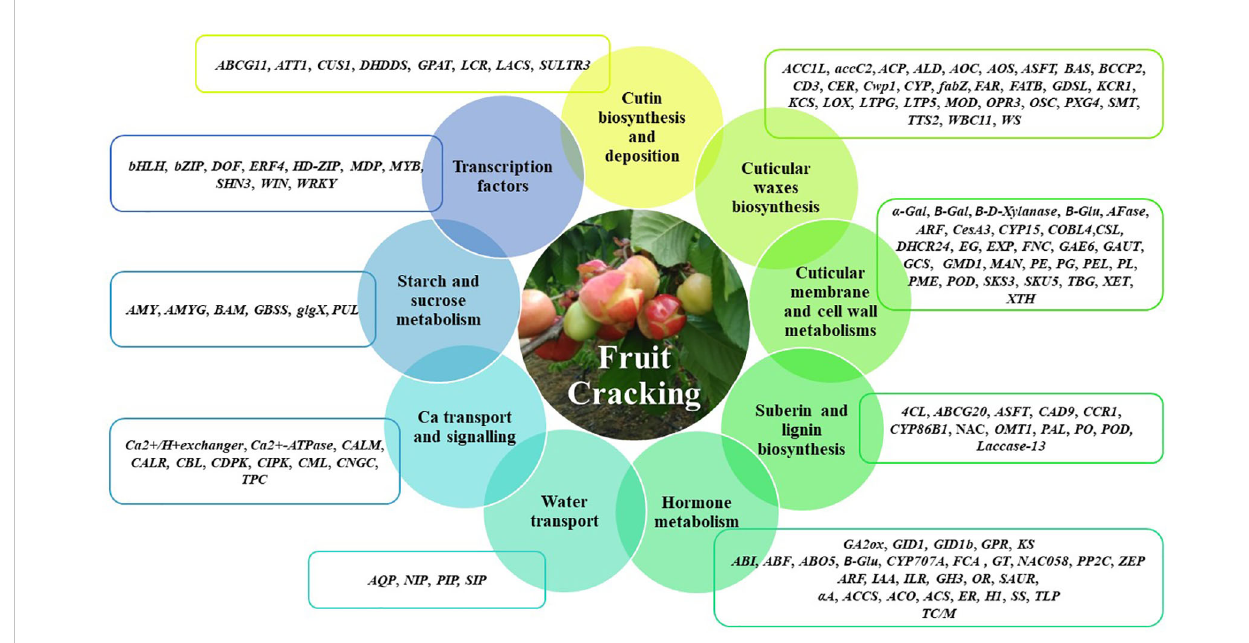
FIGURE 1 Main gene classes potentially involved in fruit cracking. The genes described belong to the molecular functions of cutin biosynthesis and deposition, cuticular waxes biosynthesis, cuticular membrane and cell wall metabolisms, suberin and lignin biosynthesis, hormone metabolism, water transport, Ca transport and signaling, starch and sucrose metabolisms and transcription factors. Cutin biosynthesis and deposition - ABCG11 (ATP binding cassette transporter), ATT1 (Cytochrome P450 oxidase CYP86A2), CUS1 (cutin synthase 1), DHDDS (ditrans,polycis-polyprenyl diphosphate synthase), GPAT (Glycerol-3-phosphate acyltransferase), LCR (Cytochrome P450 oxidase CYP86A8), LACS (Long chain fatty acid – CoA synthetase), SULTR3 (sulfate transporter 3) ; Cuticular waxes biosynthesis - ACC1L (acetyl-CoA carboxylase 1-like), accC2 (biotin carboxylase 2, chloroplastic), ACP (Acyl carrier protein), ALD (aminotransferase ALD, chloroplastic-like), AOC (oxide cyclase), AOS (allene oxide synthase), ASFT (Aliphatic suberin feruloyl- transferase), BAS (Beta-amyrin synthase), BCCP2 (biotin carboxyl carrier protein of acetyl-CoA carboxylase 2, chloroplastic), CD3 (cutin de fi cient 3), CER (Eceriferum family), Cwp1 (cuticular water permeability), CYP (cytochrome-P450 family), fabZ (3-hydroxyacyl-[acyl-carrier-protein] dehydratase FabZ-like), FAR (fatty acyl reductase), FATB (Fatty acyl – ACP-thioesterase B), GDSL (GDSL l ı ́ pase), KCR1 (b-Ketoacyl-CoA reductase 1), KCS ( b - ketoacyl-CoA synthase), LOX (lipoxygenase), LTPG (glycosylphosphatidylinositol-anchored lipid protein), LTP5 (lipid transfer protein 5), MOD (Microsomal oleate desnaturase), OPR3 (12-oxophytodienoate reductase 3), OSC (oxidosqualene cyclase), PXG4 (Putative peroxygenase 4), SMT (24- methylenesterol C-methyltransferase), TTS2 (triterpene synthase 2), WBC11 (ABC-transporter WBC11), WS (wax synthase) ; Cuticular membrane and cell wall metabolisms - a -Gal ( a - galactosidase), B-Gal ( b -galactosidase), B-Glu ( b -glucosidase), AFase (alpha-L-arabinofuranosidase), ARF (arabinofuranosidase), CesA3 (cellulose synthase), CYP15 (cytochrome P450 monooxygenase/hydrolase), COBL4 (COBRA-like gene 4), CSL (Cellulose synthase-like), DHCR24 (Delta24-sterol reductase), EG (endoglucanase), EXP (Expansin), FNC (Fruit netted-cracking gene), GAE6 (UDP- glucuronate 4-epimerase), GAUT (alpha-1,4-galacturonosyltransferase), GCS (Gamma-glutamylcysteine synthetase, gamma-GCS), GMD1 (GDP- mannose 4,6-dehydratase 1), MAN (Beta-mannanendohydrolase), PE (pectinesterase), PG (polygalacturonase), PEL/PL (pectate lyase), PME (pectin methylesterase), POD (Peroxidase), SKS3 (Pectinesterase-like), SKU5 (Pectinesterase-like), TBG (tomato b -galactosidase), XET (xyloglucan: xyloglucosyl transferase), XTH (Xyloglucan endotransglycosylase/hydrolase) ; Suberin and lignin biosynthesis - 4CL (4-coumaric acid, CoA ligase), ABCG20 (ATP-Binding cassette G20), ASFT (aliphatic suberin feruloyl-transferase), CAD9 (cinnamyl alcohol dehydrogenase9), CCR1 (cinnamoyl CoA reductase), CYP86B1 (Cytochrome P450), NAC (NAC domain containing protein), OMT1 (O-methyltransferase1), PAL (phenylalanine ammonia lyase), PO/POD (Peroxidase) ; Hormone metabolism - GA2ox (Gibberellin 2-oxidase), GID1 (GA insensitive DWARF1), GPR (Gibberellin-regulated protein), KS (ent-kaurene synthase), ABI (ABA insensitive), ABF (ABRE-binding factors), ABO5 (ABA overly-sensitive 5), B-Glu ( b -glucosidase), CYP707A (ABA 8 ’ - hydroxylase), FCA (Flowering time control protein A), GT (ABA glycosyltransferase), NAC058 (ABA signaling gene - NAC Domain containing protein58), PP2C (Protein phosphatase 2C), ZEP (Zeaxanthin epoxidase), ARF (Auxin response Factor), IAA (indole-3-acetic acid), ILR (IAA-amino acid hydrolase), GH3 (IAA-amido synthetase), OR (Oxidoreductase) (NAD+ oxidoreductase), SAUR (Small Auxin Up-Regulated genes), a A (alpha-amylase), ACCS (Aminocyclopropanecarboxylate synthase), ACO (1-aminocyclopropane-1-carboxylic acid oxidase), ACS (1-aminocyclopropane-1-carboxylic acid synthase), ER (Ethylene receptor), H1 (Hydrolase), SS (sucrose synthase), TLP (Thaumatin-like protein), TC/M (terpene cyclase/mutase) ; Water transport - AQP (Aquaporin), NIP (Aquaporin), PIP (Plasma membrane intrinsic protein), SIP (Aquaporin) ; Ca transport and signalling - CALM (Calmodulin), CALR (Calreticulin), CBL (calcineurin B-like protein), CDPK (Ca 2+ -dependent protein kinases), CIPK (CBL-interacting serine/threonine- protein kinase), CML (Calmodulin-like protein), CNGC (Cyclic nucleotide-gated ion Channel), TPC (putative voltage-gated Ca 2+ ) ; Starch and sucrose metabolism - AMY (alpha-amylase), AMYG (glucoamylase), BAM (beta-amylase), GBSS (granule-bound starch synthase), glgX (glycogen debranching enzyme), PUL (pullulanase) ; Transcription factors - bHLH (bHLH transcription factor), bZYP (bZIP transcription factor), DOF (DOF transcription factor), ERF4 (ethylene-responsive transcription factor 4), HD-ZIP (homeobox-leucine zipper protein), MDP (MADS box transcription factor), MYB (MYB domain protein), SHN3 ( ethylene response subfamily member) , WIN (AP2/EREBP-type transcription factor), WRKY (WRKY family transcription factor)